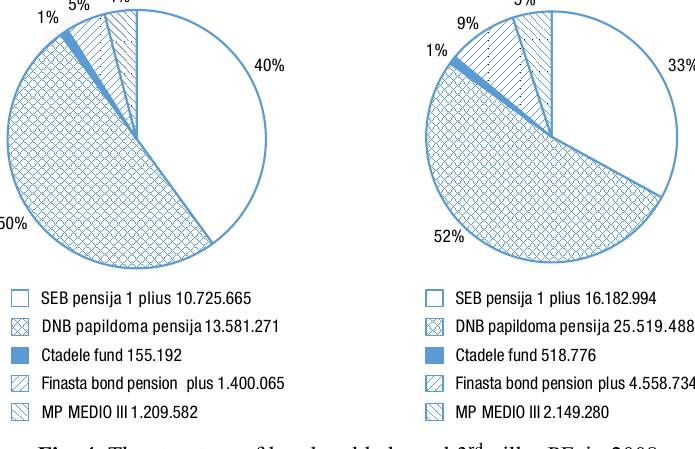
Fig. 4. The structure of bond and balanced 3 rd pillar PF, in 2008 on the left side and in 2012 on the right side Source : created by authors according to annual reports of PF.